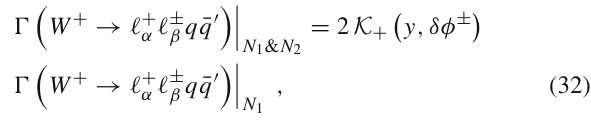
Fig. 5 Left: rescaling of the bounds on | U μ N | 2 from LHCb [83] in the presence of two HNLs. Dark blue line is the LHCb bound in the LNC searches, while in lighter blue (lower curve) is the rescaled bound for y = (cid:14) M N /(cid:9) N < 1. The dark green line is the bound in the LNV searches, which can be relaxed (upper green region) if the N 1 , 2 form a pseudo − Dirac pair ( δφ + = π , y (cid:13) 1), or strengthened